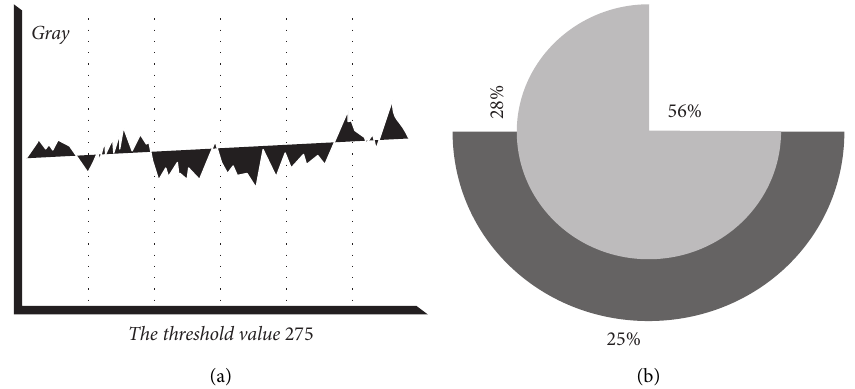
Figure 6: The threshold selection of this method.